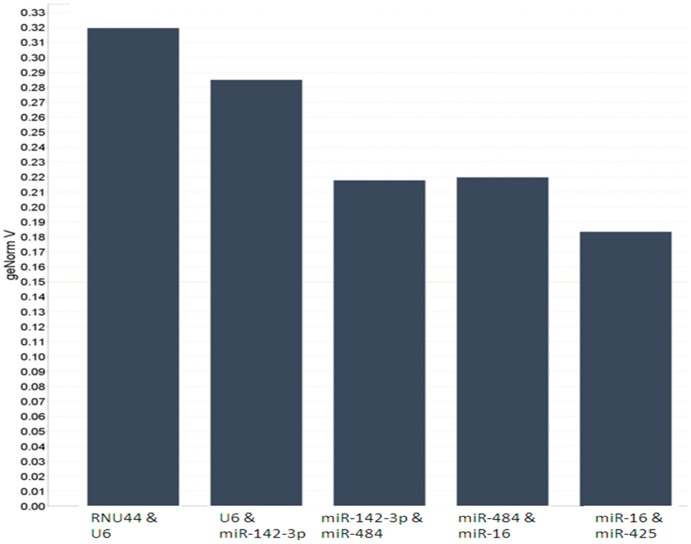
Determination of the best combination of ECs for normalization.Determination of optimum number of candidate ECs for normalization. The GeNorm programme establishes the optimum combination of candidate ECs for normalization, producing the lowest V variable. This factor is calculated using the variable ‘V’ as the pairwise variation (Vn/Vn+1) between two sequential normalization factors (NFs) (NFn and NFn+1). The combination of candidate ECs is deemed optimal when the V variable achieves the lowest value. The optimal combination was achieved by combining miR-16 and miR-425.